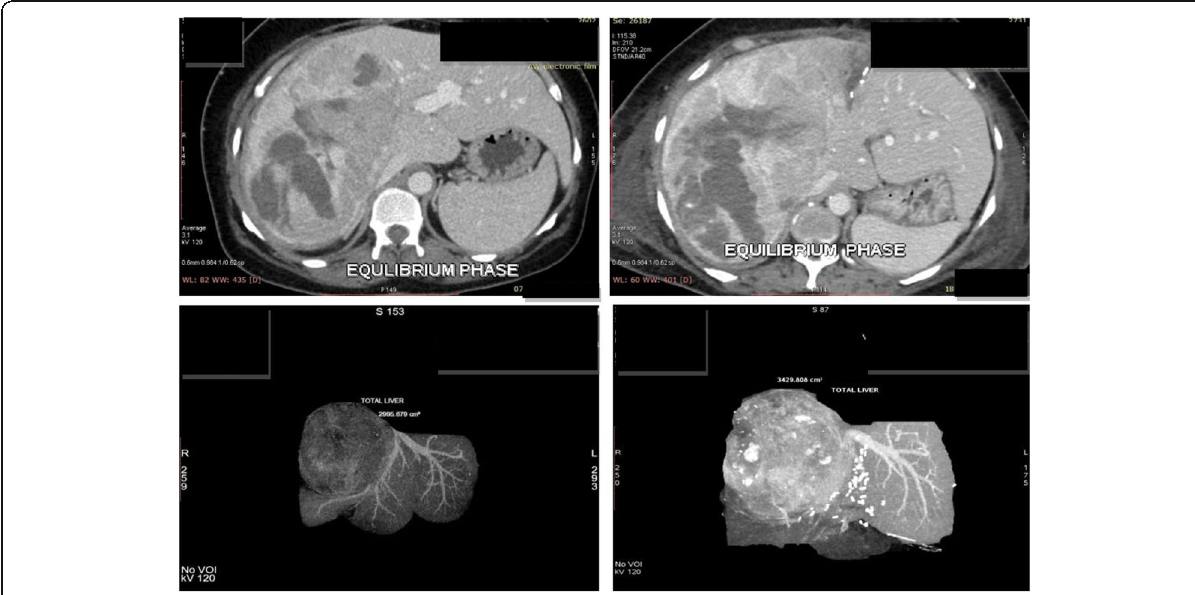
Fig. 1 CT volumetry images before and after 1st stage of ALPPS showing hypertrophy of segments 2 and 3 after ALPPS